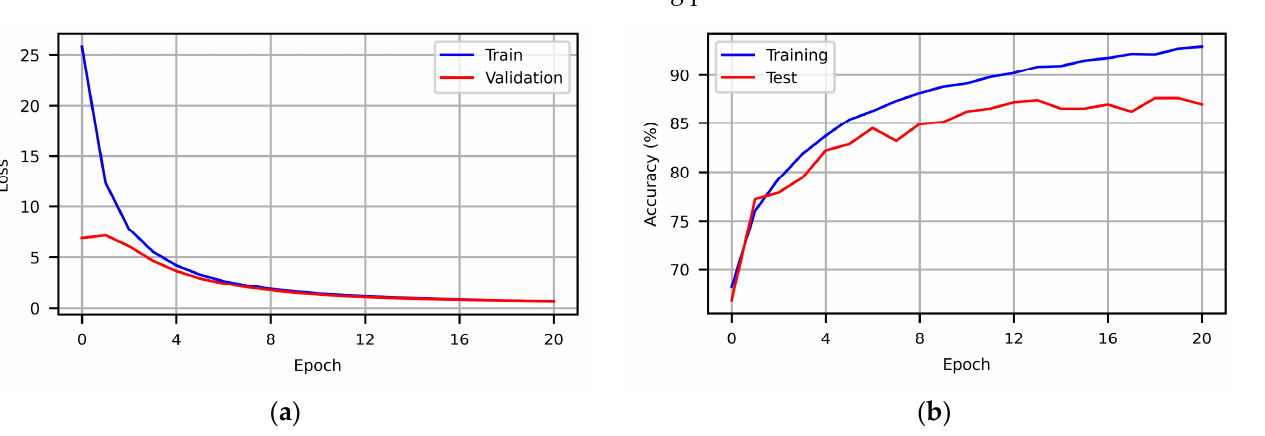
Figure 9. Convergence of ( a ) loss and ( b ) accuracy of DCNN stage of the proposed model.